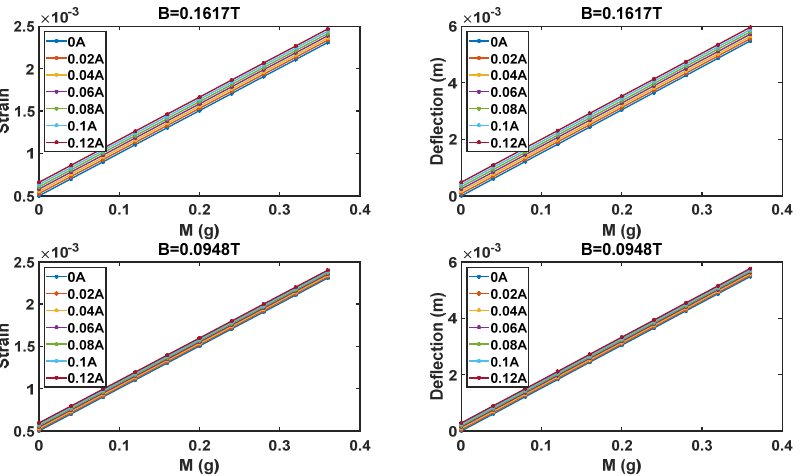
Figure 4. The strain and the deflection of the beam, as a function of the target mass and the driving current, in the case of two B intensities (0.0948 T, 0.1617 T).